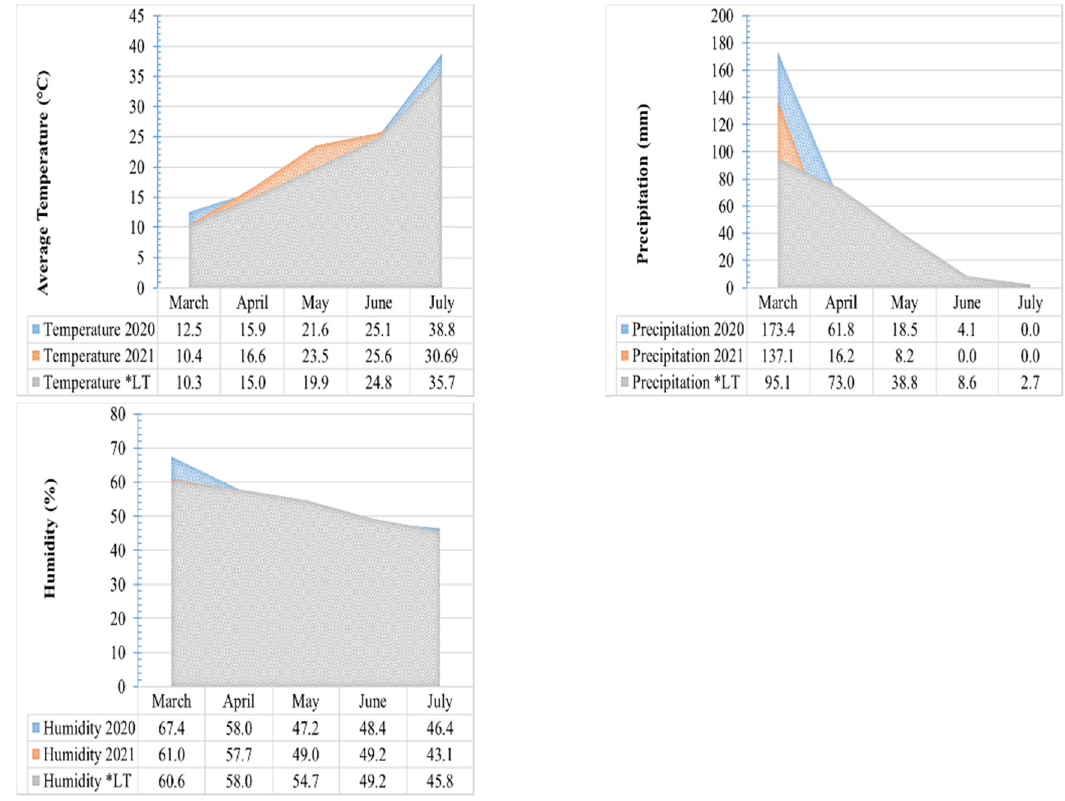
Figure 1: Climatic conditions of the experimental area.